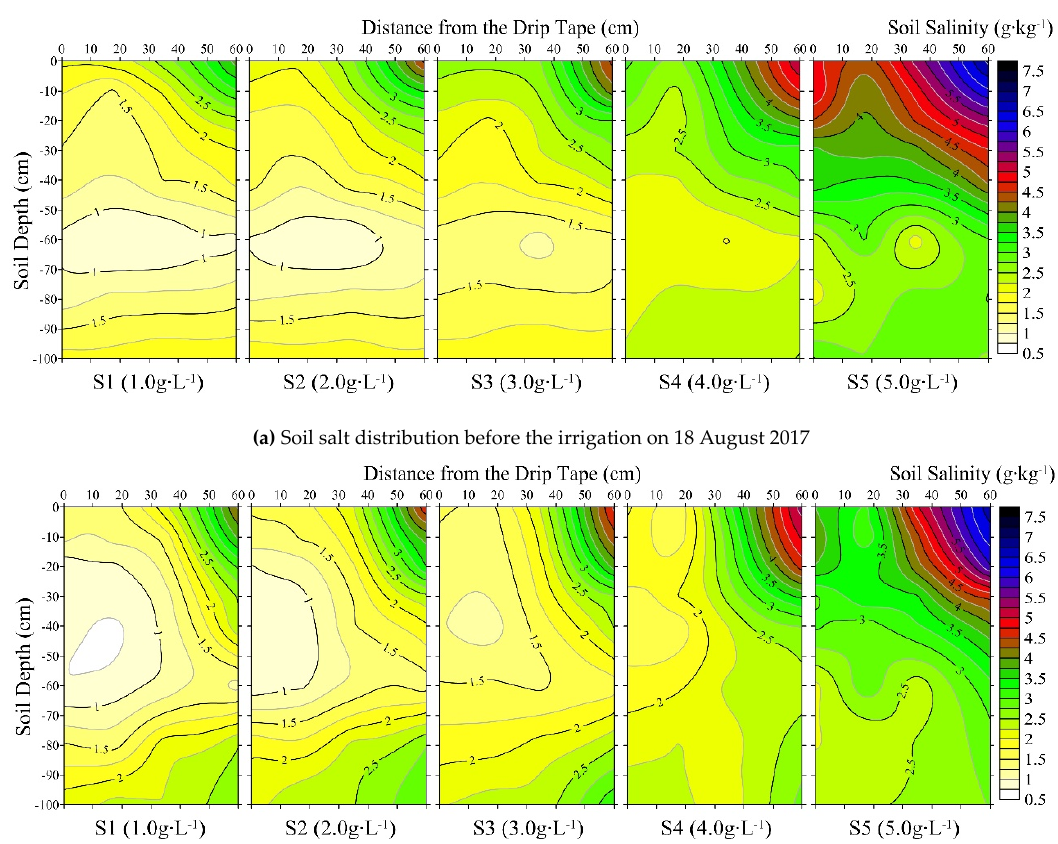
Figure 8. Soil salt distribution for di ff erent irrigation water